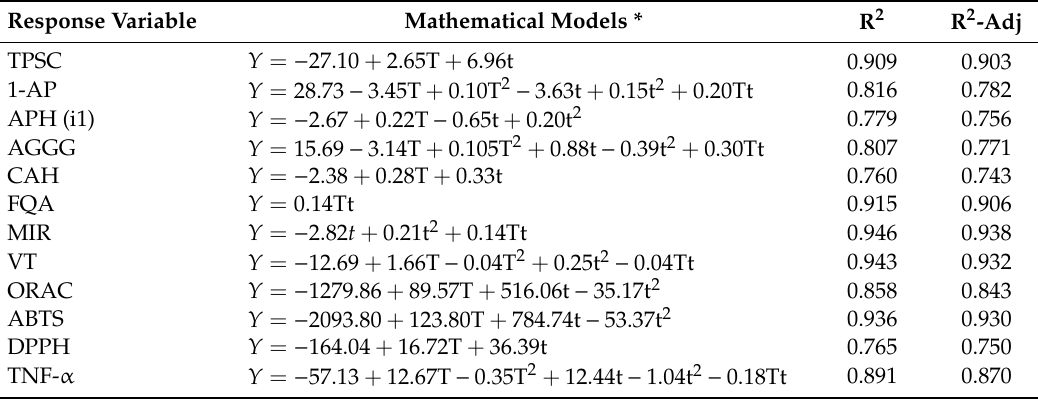
Table 3. Analysis of variance and regression coe ffi cients of the predicted models for the response variables of germinated